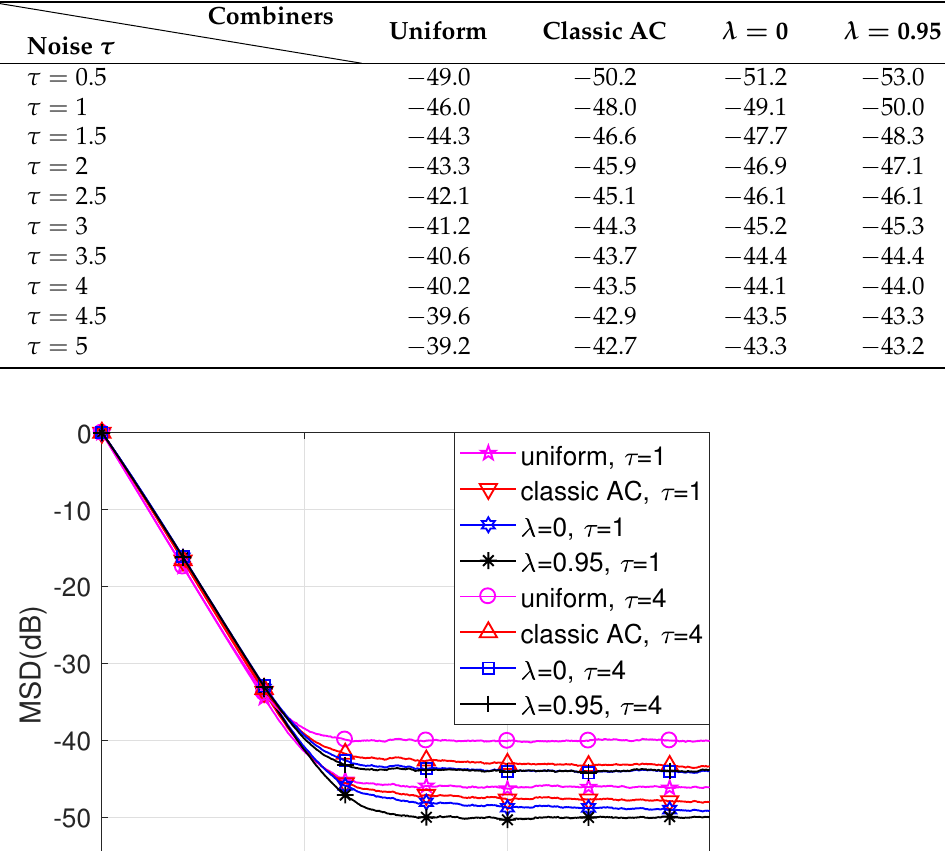
Table 1. The steady-state MSD with respect to the variation of the noise power.